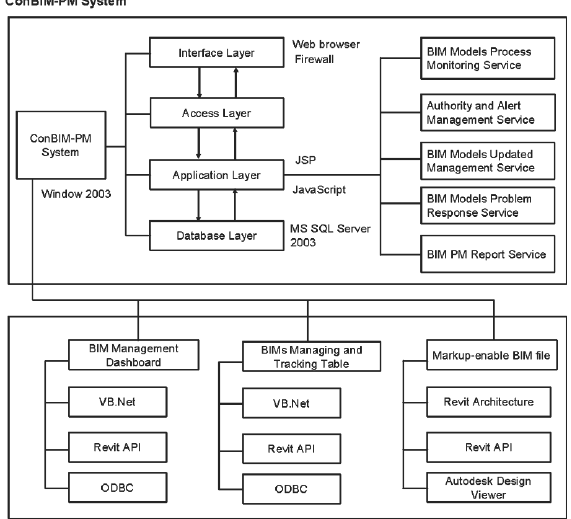
Fig. 3. Development framework of ConBIM-PM